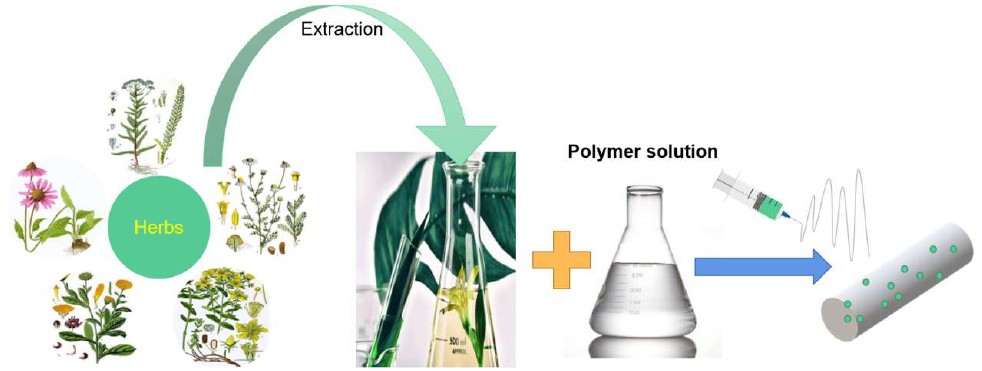
Figure 1. Fabrication process (plant image for reference), reprinted with permission from [77] copyright 2020, Springer Nature.